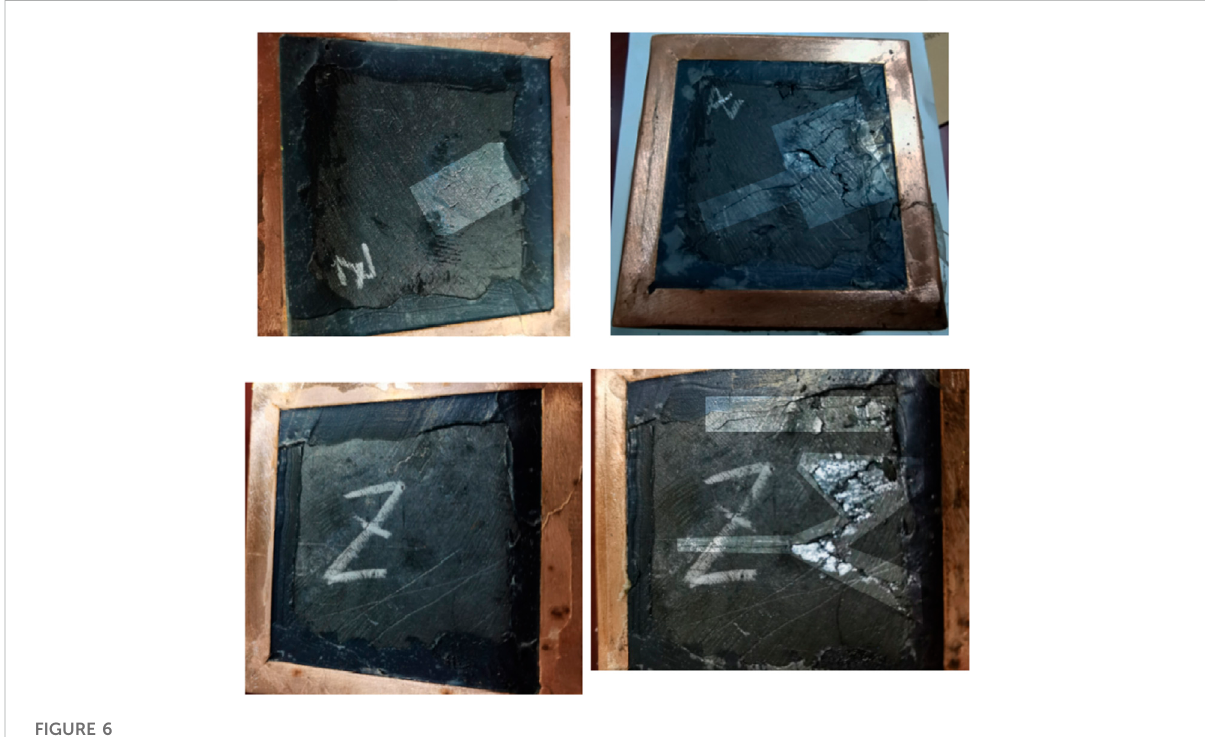
FIGURE 6 Comparison of the Z plane before (left) and after (right) the experiment. Note: The fractures are highlighted with transparent frames. Fractures develop along the direction of the microcracks.